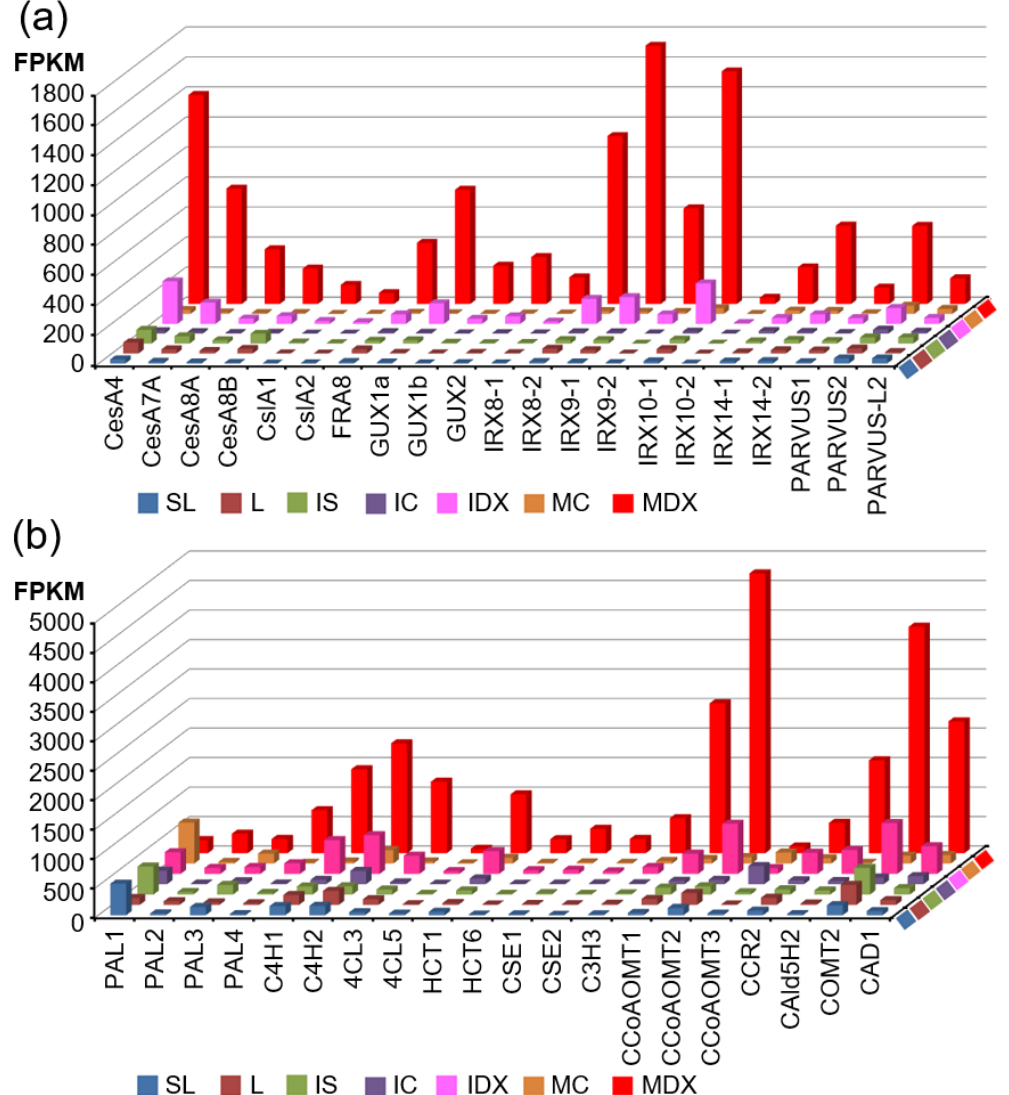
Figure 5. Wood-forming tissue-specific expression of secondary wall biosynthetic genes in poplar. Transcript abundance of all secondary wall biosynthetic genes in each tissue was plotted. ( a ) Genes